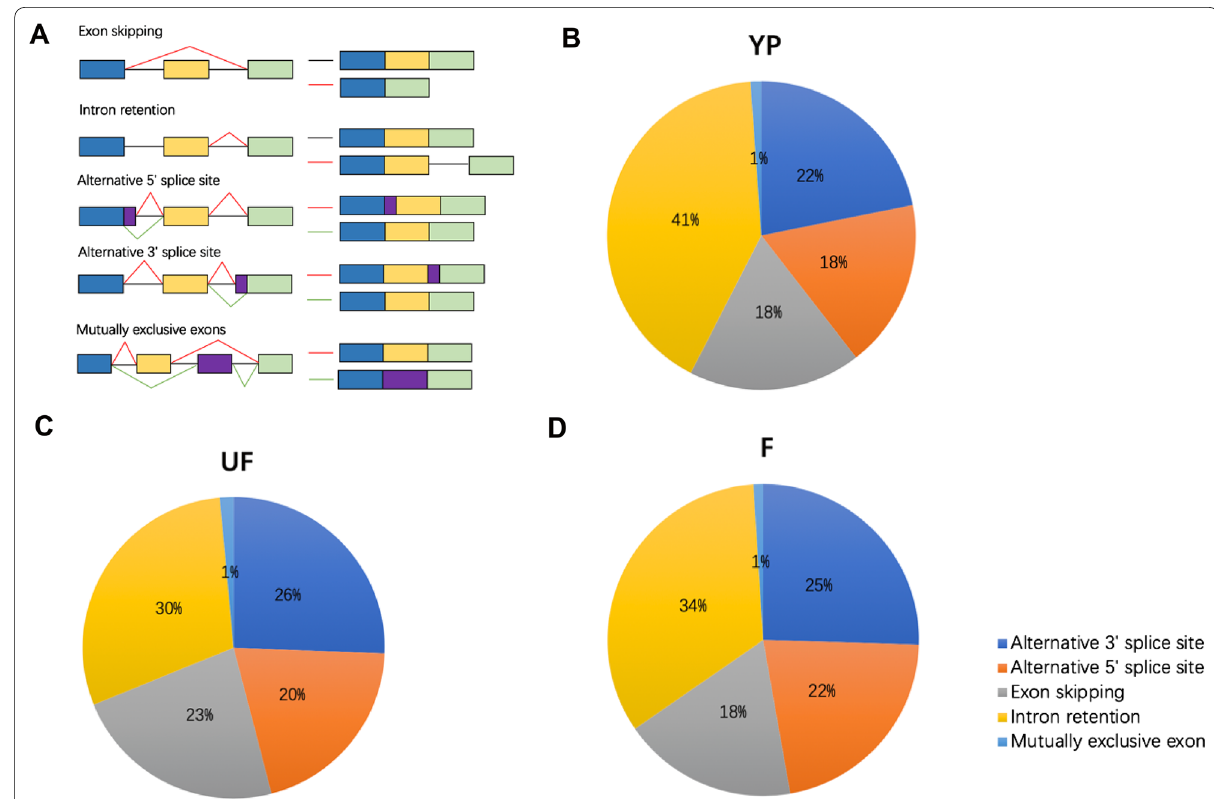
Fig. 1 Alternative splicing landscapes of rice young panicles (YP), unfertilized florets (UF), and fertilized florets (F) based in the Nanopore sequencing data. a Alternative splicing (AS) types, namely Alternative 3 ′ splice site (A3SS), Alternative 5 ′ splice site (A5SS), Exon skipping (ES), Intron retention (IR), and Mutually exclusive exons (MEE). b – d Frequency of each AS types in sample of YP, UF and F,